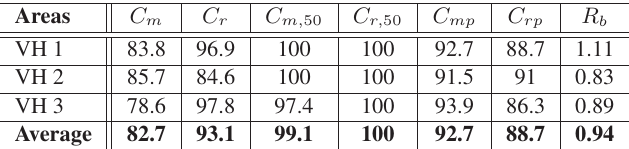
Table 1: Building detection results for the Vaihingen (VH) data set. Object-based: C m = completeness and C r = correctness ( C m, 50 and C r, 50 are for buildings over 50m 2 ) in percentage. Pixel-based: C mp = completeness and C rp = correctness in per- centage. Geometric: R = planimetric accuracy in b